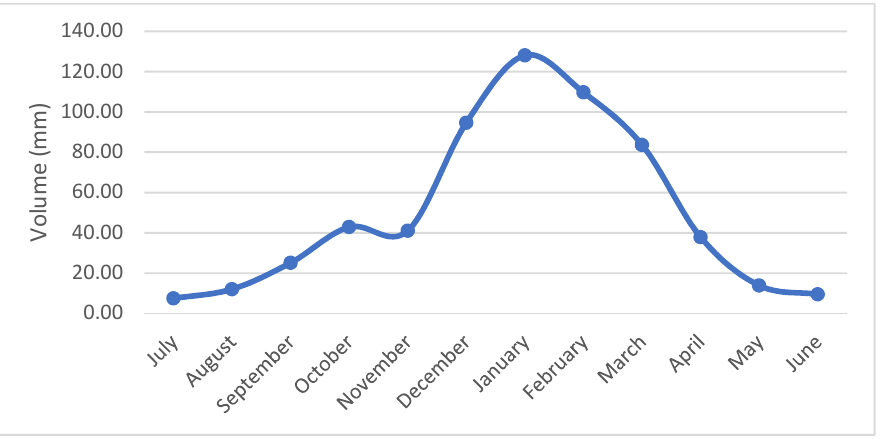
Figure 1. Precipitation total in Milluni. Source: Own elaboration based on data from SENAMHI, 2021